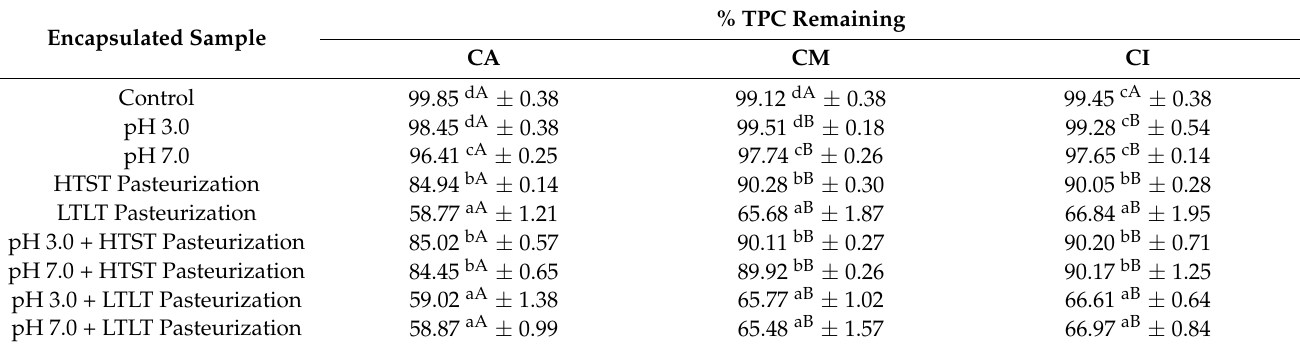
Table 7. % TPC remaining of alginate, alginate/maltodextrin, and alginate/inulin hydrogel beads containing encapsulated antioxidant crude extract from CSCG after simulated food process condi- tions.